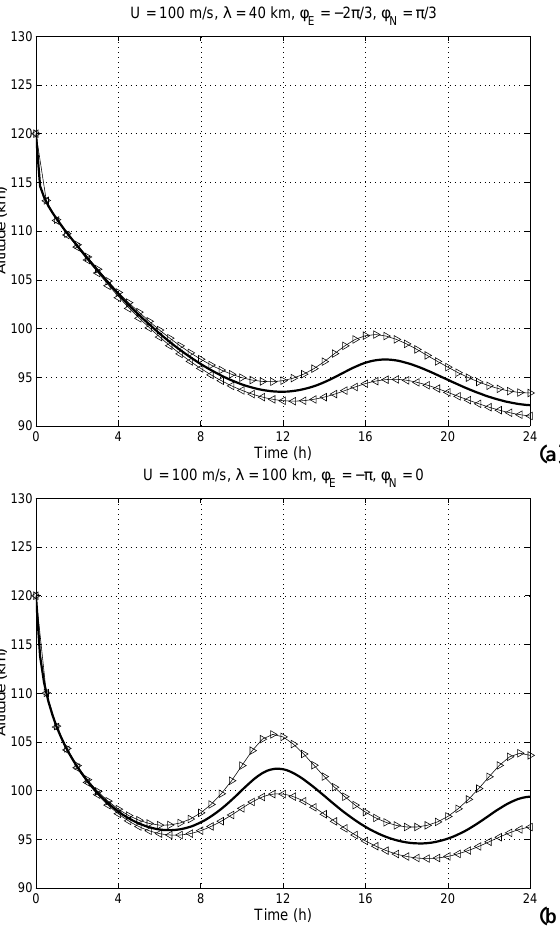
Fig. 3. The same as for Fig. 2 but for tidal amplitudes, U , of 100m/s.